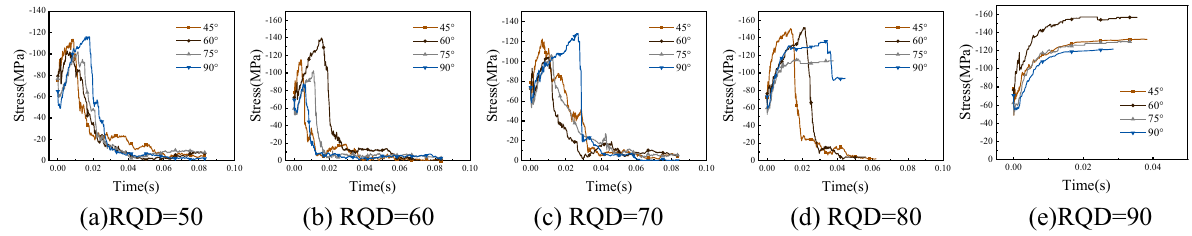
(a)RQD=50 Fig. 21 Tangential stress with different inclined angles of joints in the same RQD ( σ